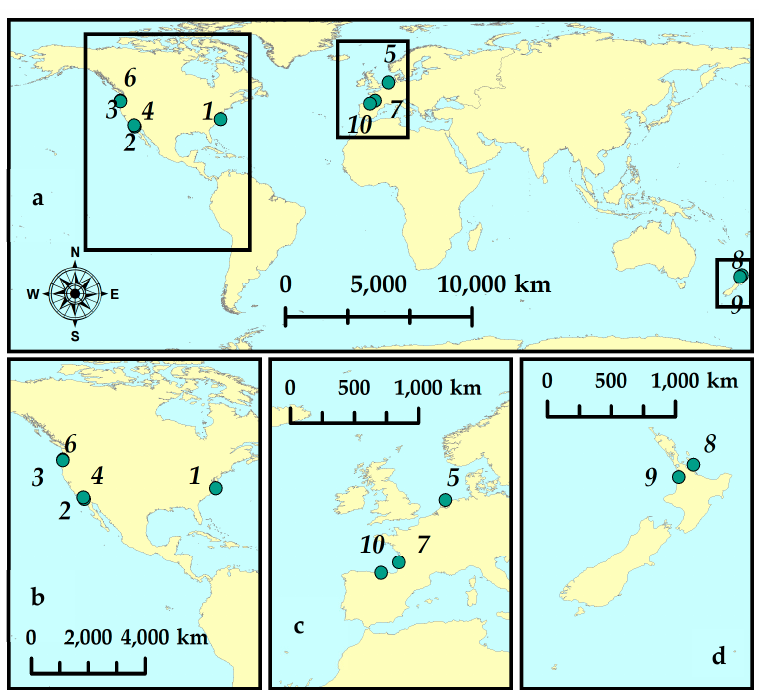
Figure 1. Location of sites previously studied, listed in Table 1, showing variation between ocean-facing and fetch-limited sites: ( a ); world map; ( b ) United States of America (USA); ( c ) Western Europe; ( d ) New Zealand.